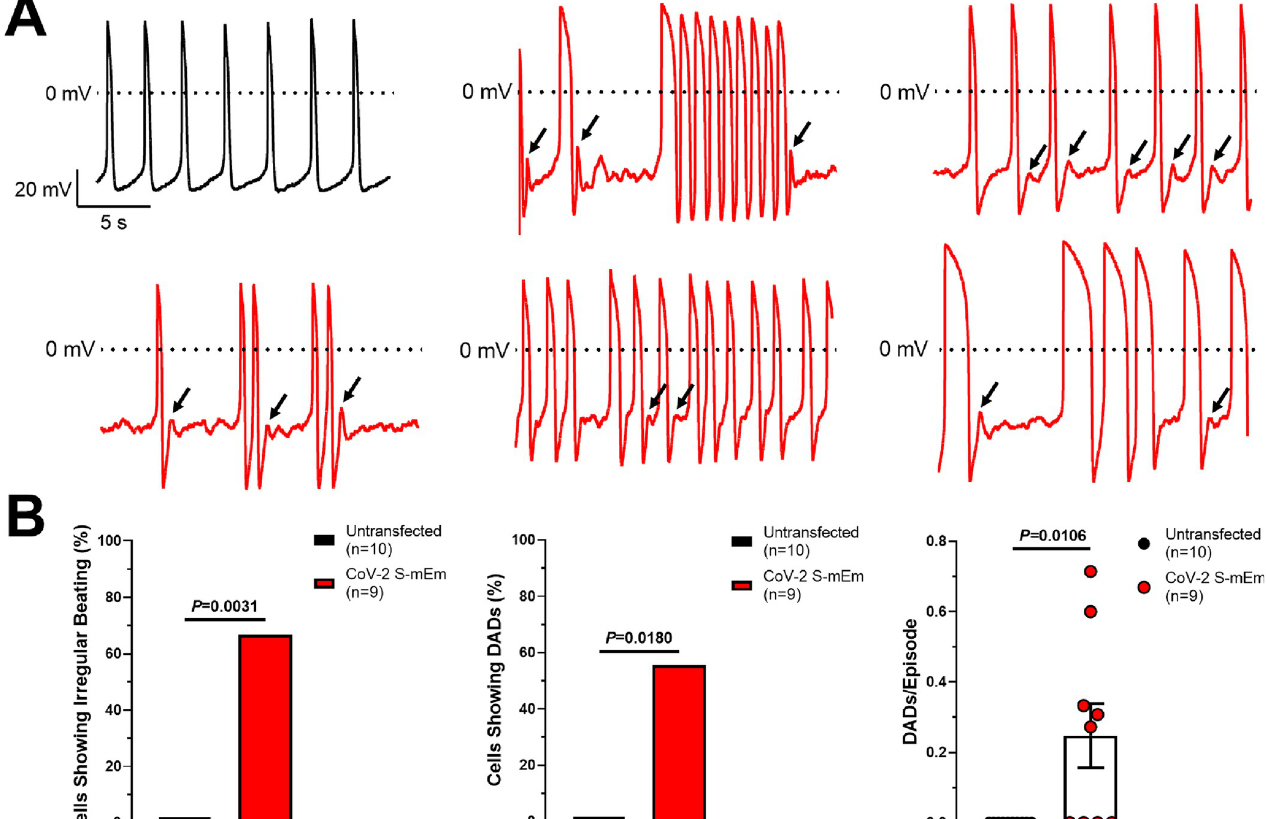
Fig 3. SARS-CoV-2 spike protein-induced hiPSC-CM syncytia display cellular arrhythmias. ( A ) Representative action potential traces derived from untransfected hiPSC-CMs showing regular beating (black) and CoV-2 S-mEm-transfected hiPSC-CMs displaying erratic beating and delayed afterdepolarizations (DADs; red). Black arrows indicate individual DADs. ( B ) Quantification of the number of untransfected (n = 10) or CoV-2 S-mEm- transfected (n = 9) hiPSC-CMs showing irregular beating (left) or delayed afterdepolarizations (DADs; middle) as well as the rate at which DADs occur (DADs/episode; right). Graphs depicting categorical data are presented as percentage, and Fischer’s exact tests were used to determine significance. Graphs depicting continuous data are presented as mean ± SEM, and unpaired two-tailed Student’s t-tests were used to determine significance.